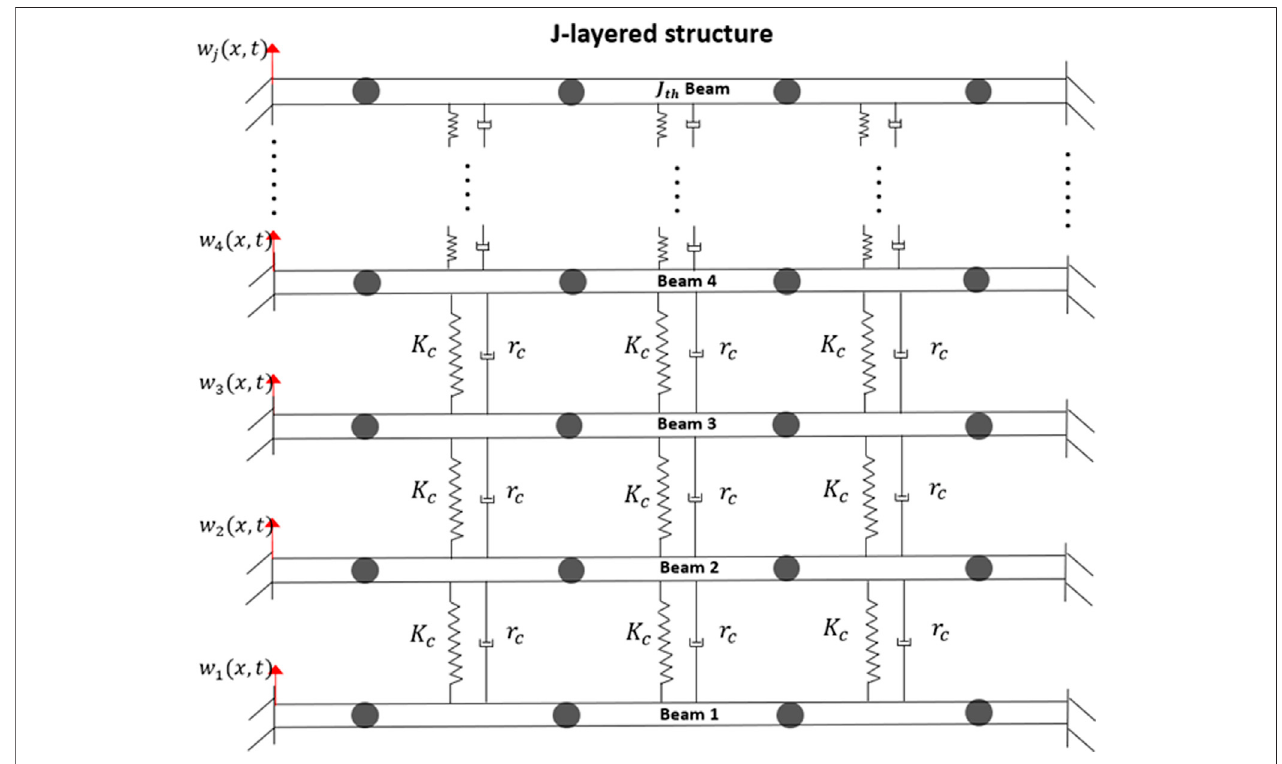
FIGURE 2 | Schematic diagram of the free body diagram for the vertical beams attached to each unit cell and between the horizontal beams of a j-layered metamaterial structure.